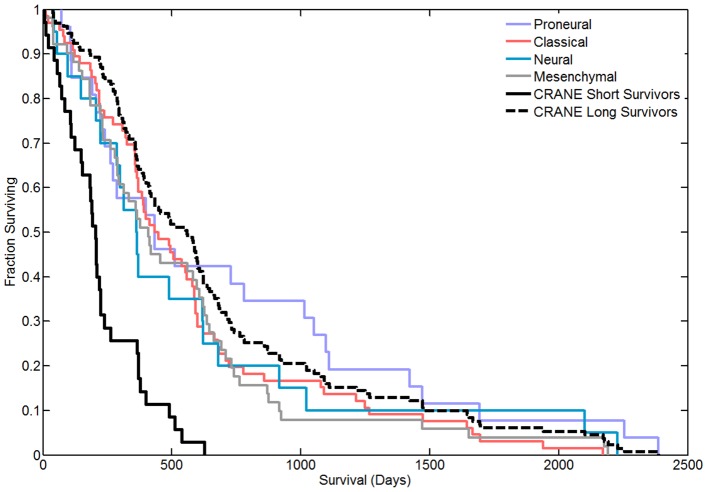
Survival curves comparing various classifiers when tested on the dataset of Lee et al.(GEO ID: GSE13041). While the Verhaak subtypes – Proneural, Classical, Neural, and Mesenchymal – do not show statistically significant differences in survival, the top 5 CRANE subnetworks clearly distinguish short-term from long-term survivor groups.